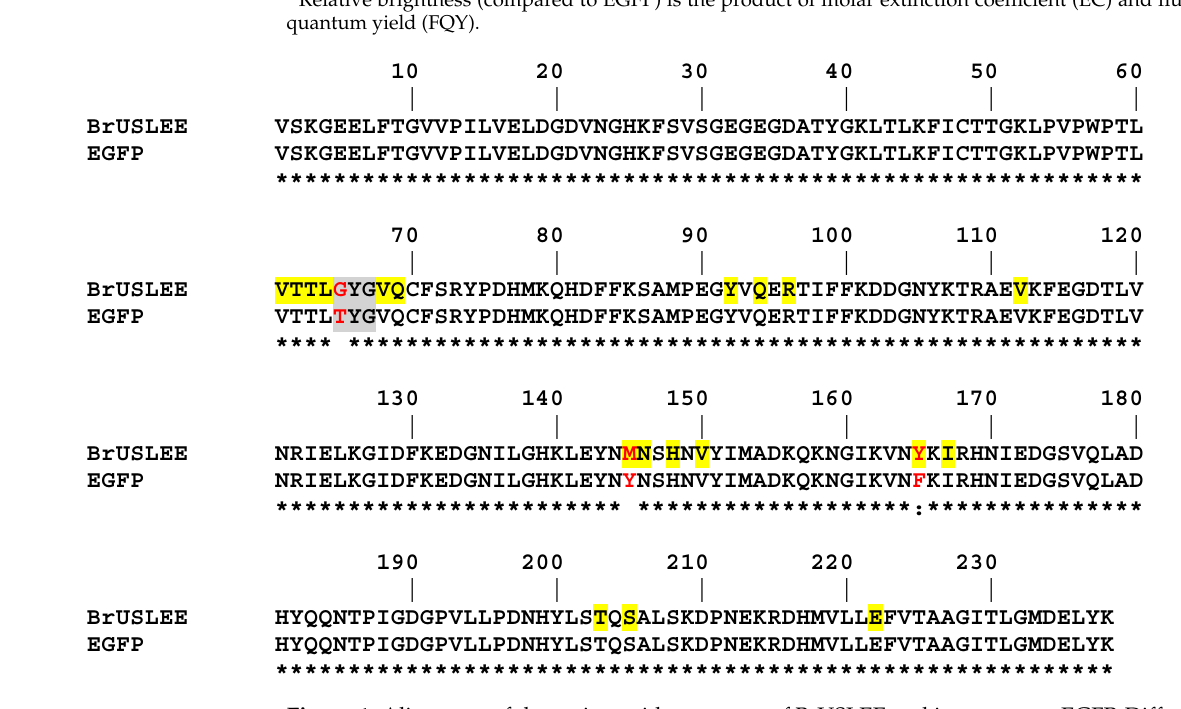
Figure 1. Alignment of the amino-acid sequences of BrUSLEE and its precursor EGFP. Differences are shown in red. The chromophore-forming triad is highlighted in gray. Residues from the chromophore nearest environment (<4 Å), which stabilize the chromophore by H-bonds (direct or via water) or hydrophobic interactions, are highlighted in yellow. The identical residues are marked with *, and the similar ones with :.